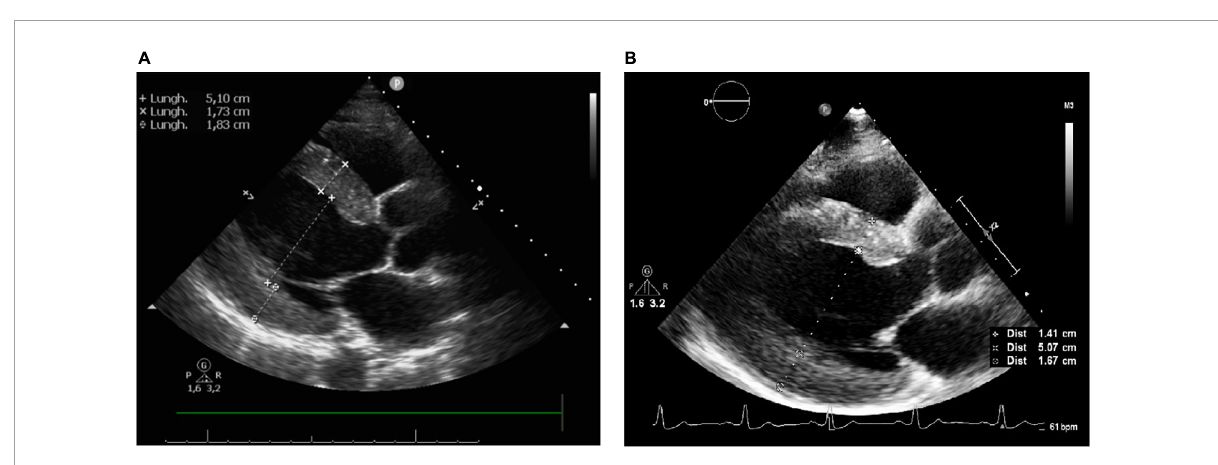
FIGURE5 (A) Echocardiography after 2 months since the admission. (B) Echocardiography after 4 months since the